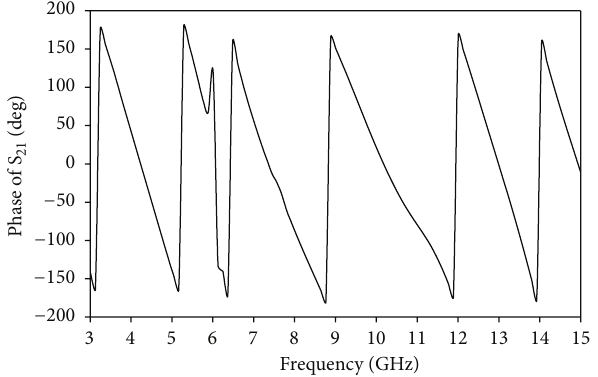
Figure 12: Phase of S 21 of the proposed notched antenna.